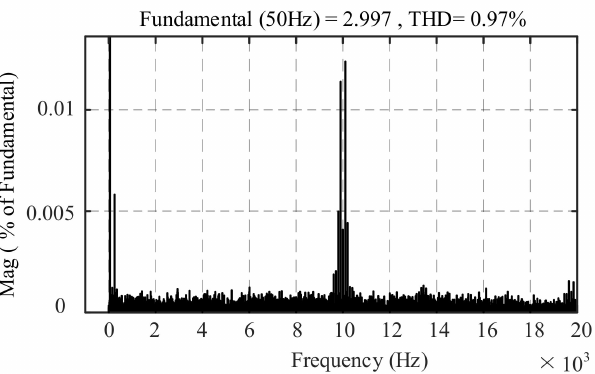
Figure 9. Spectrum analysis of A-phase current of novel FCS-MDPC.